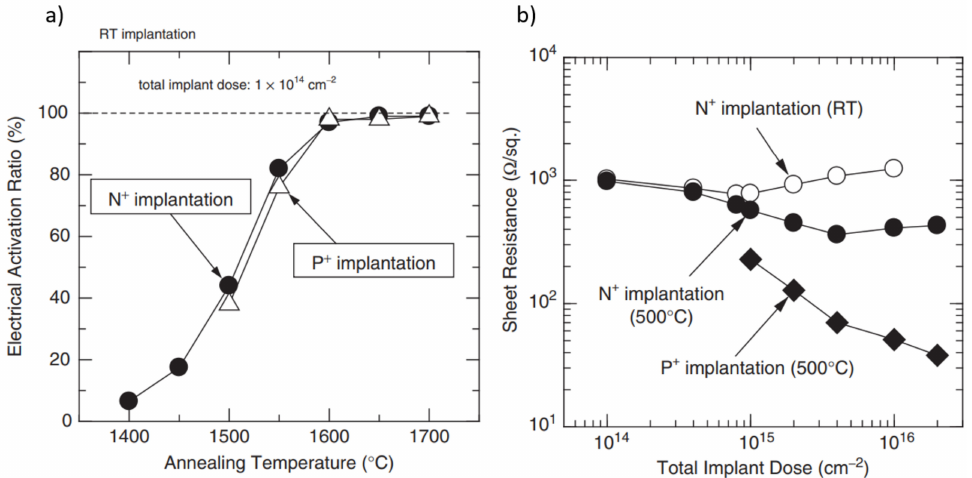
Figure 10. ( a ) Annealing-temperature dependence of the electrical activation ratio in nitrogen- (N) or phosphorus (P)-implanted SiC. ( b ) Sheet resistance versus the total implant dose for N- or P- implanted SiC annealed at 1700 ◦ C for 30 min [125]. Copyright © 2022 John Wiley & Sons, Singapore Pte.